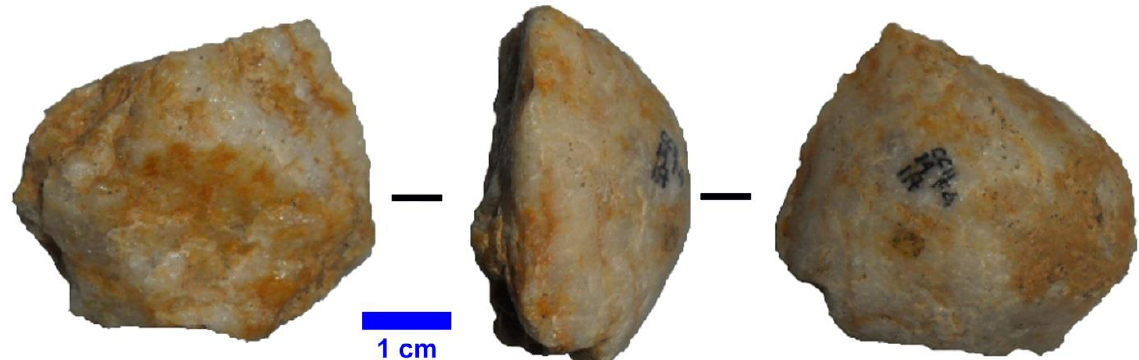
Figure 7. Levallois core with cortical striking platform from the Ciota Ciara cave. The scale bar in the image is 1 cm